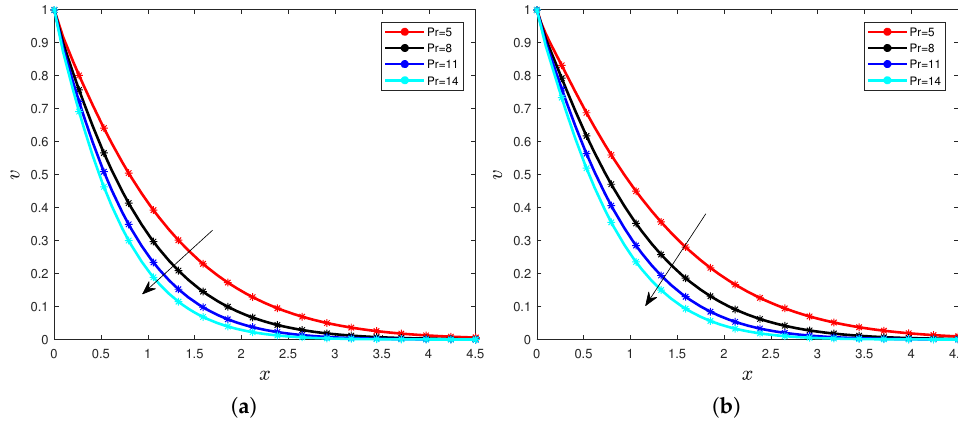
Figure 9. Temperature for different values of the Prandtl number with α = 0.65 ( a ) and α = 0.75 ( b ).